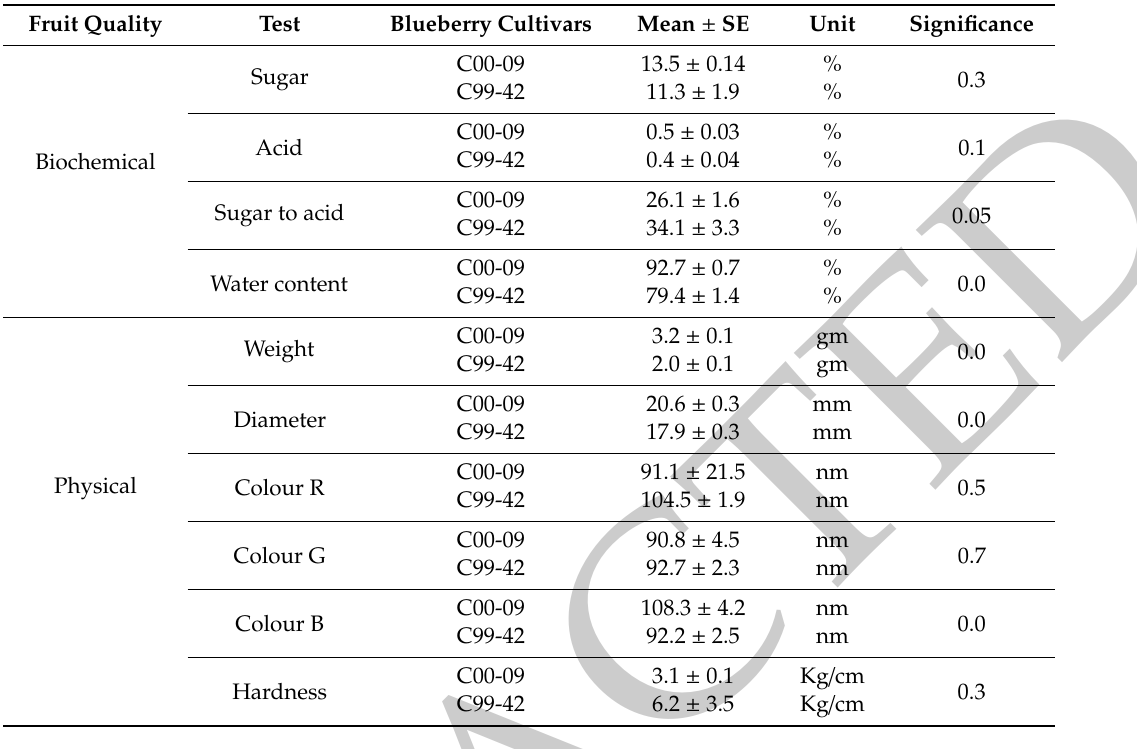
Table 1. Fruit quality assessment includes biochemical and physical quality of blueberry cultivars C00-09 and C99-42 before cold treatment. Fruit